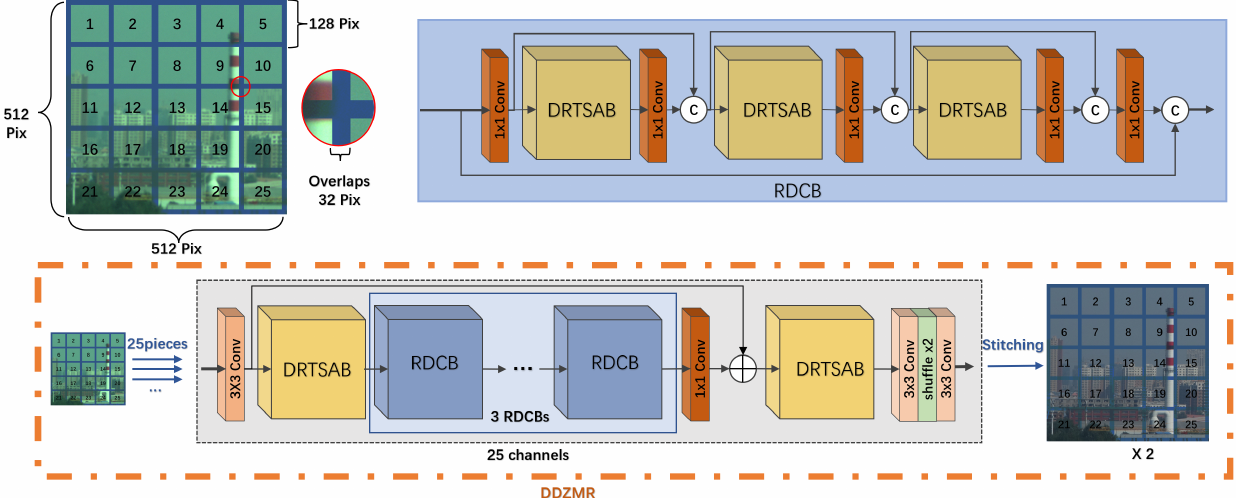
Figure 4. Deep dense zoned multipath residual network.